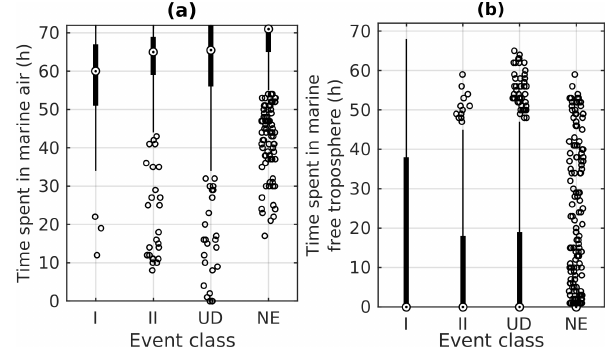
Figure 3. Time the air mass has spent in (a) marine air and (b) ma- rine free troposphere between 8:00–15:00 during days classified as Class I (I), Class II (II), undefined (UD), and non-event (NE) days. The circles are the median concentrations for each month, black boxes mark the 25th and 75th percentiles, and the rest of the points are outside this